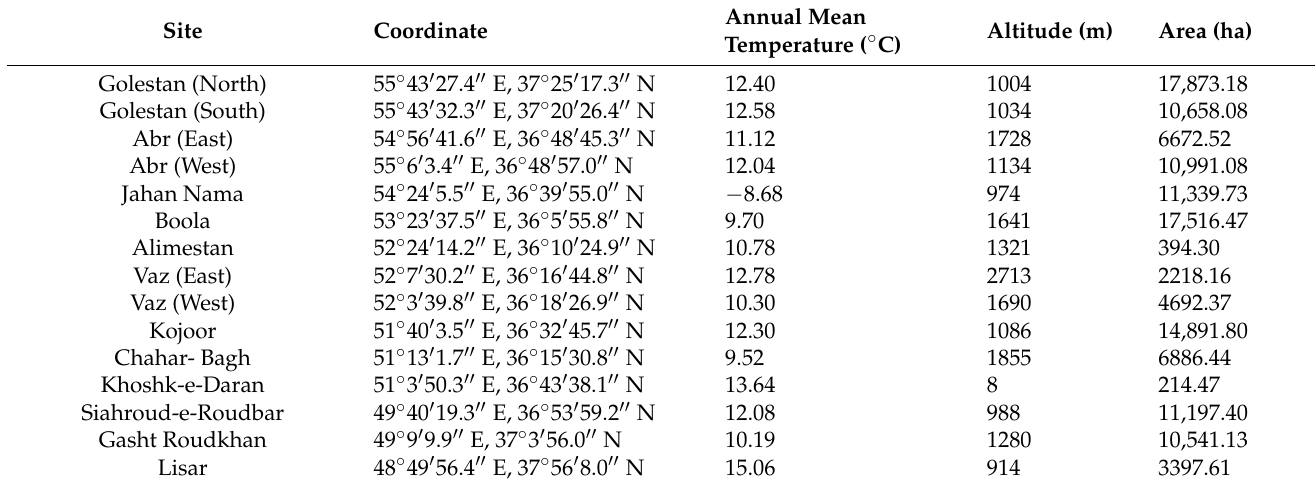
Table 1. General characteristics of the 15 UNESCO-inscribed sites across HF shown in Figure